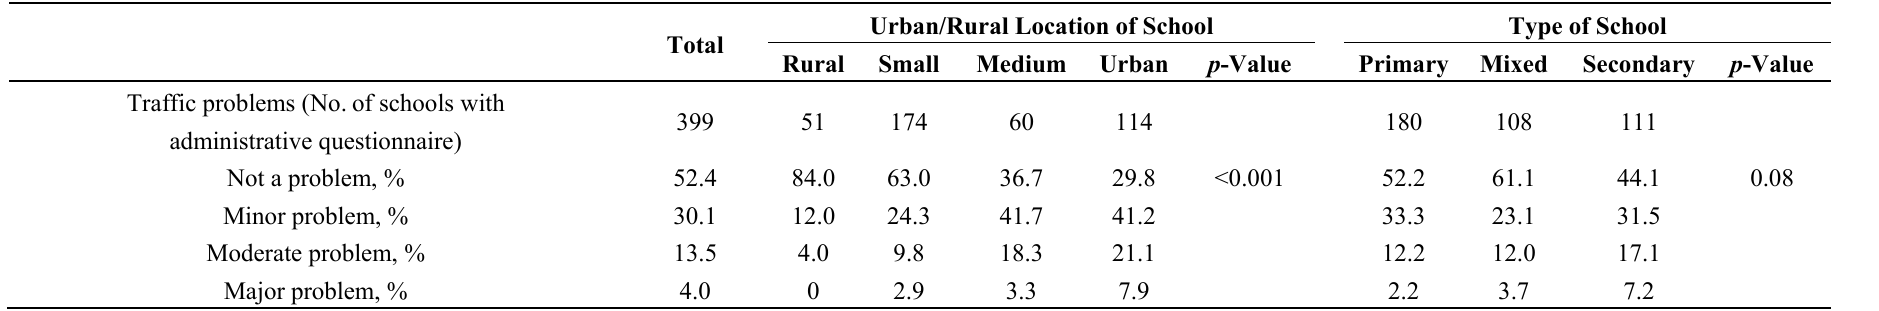
Table 3. Perceived traffic problems in the neighbourhoods surrounding Canadian schools. Urban/Rural Location of School Type of School Total Rural Small Medium Urban p -Value